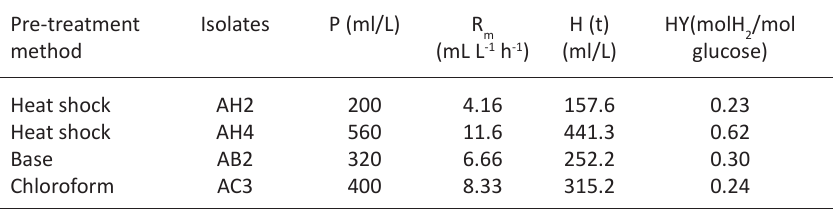
- Cumulative H Production, HY – Hydrogen (t) 2